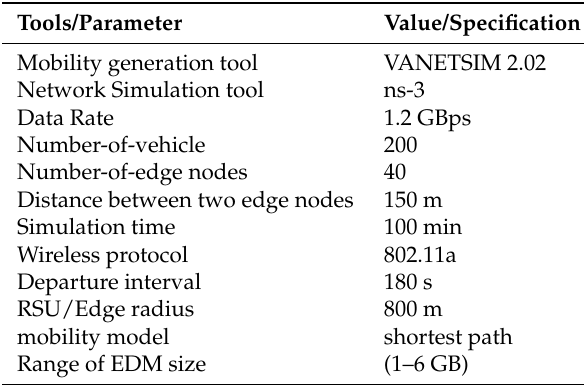
Figure 3. Overall time overhead ( a ) and signcryption time overhead ( b ). Table 5. Setting of simulation